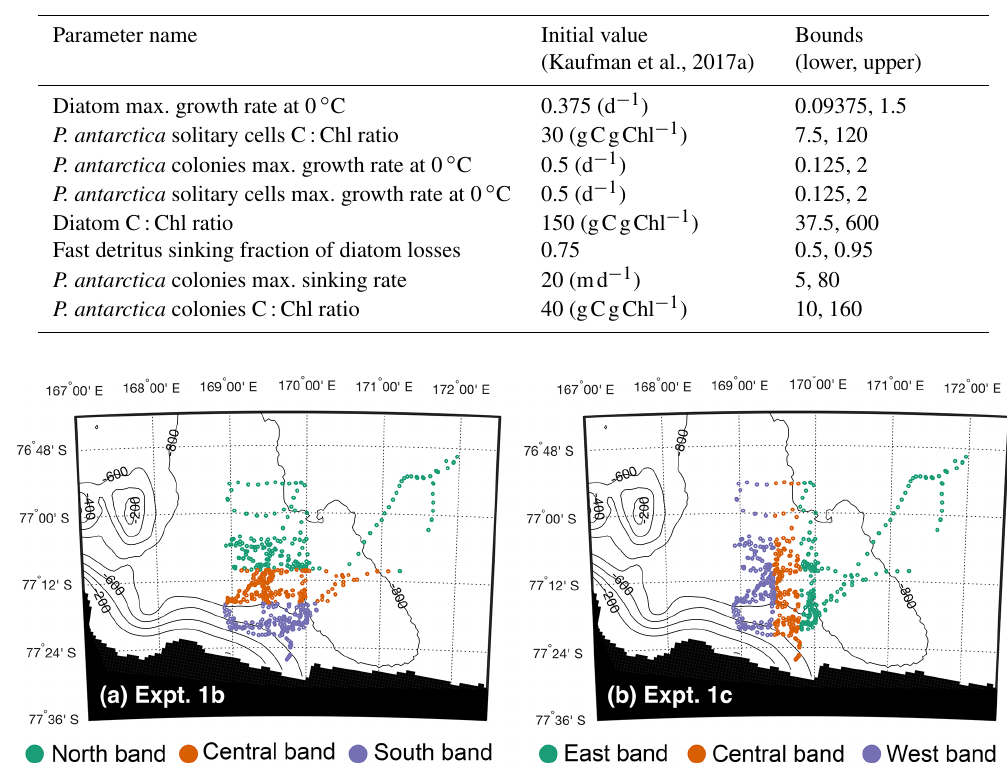
Table 1. Eight parameters optimized in this analysis.